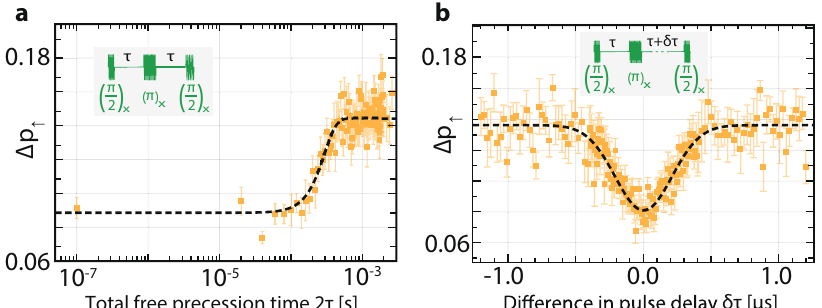
Fig. 4 Decoherence and dephasing times of the molecular fi ve-electron spin state. a Hahn spin echo measurement of the fi ve-electron state, plotting the measured spin-up fraction Δ p ↑ as a function of total free precession time 2 τ . b Spin echo envelope measurement with a Ramsey-type pulse sequence. The initial free precession time τ = 3 μ s is fi xed, and we plot Δ p ↑ as a function of the relative delay of the fi nal projection pulse δτ . Error bars indicate ±1 σ on the